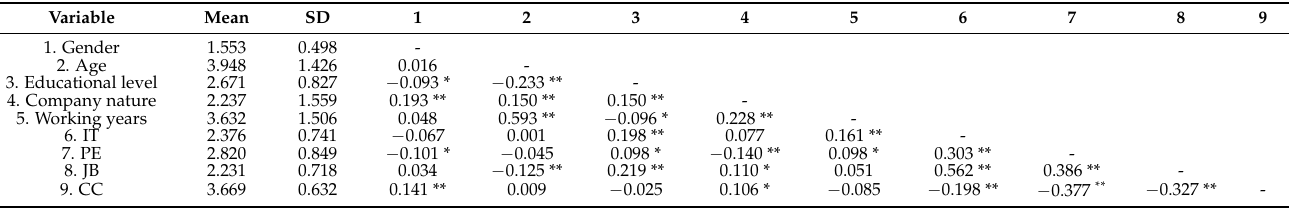
Table 3. Descriptive statistics and correlation coefficient matrix of